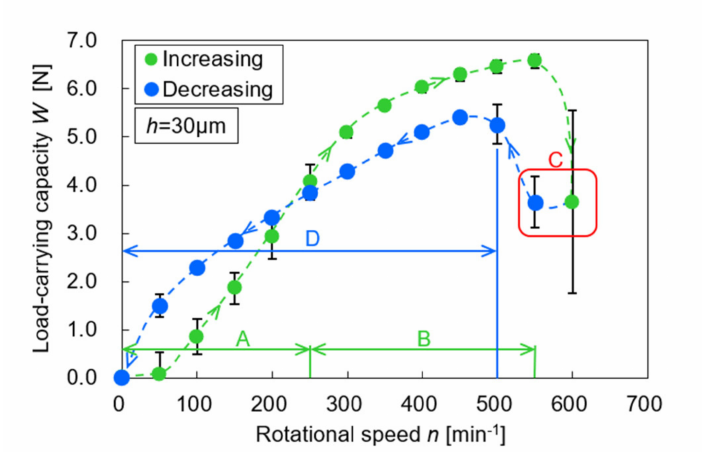
Figure 9. The load-carrying capacity of dimple